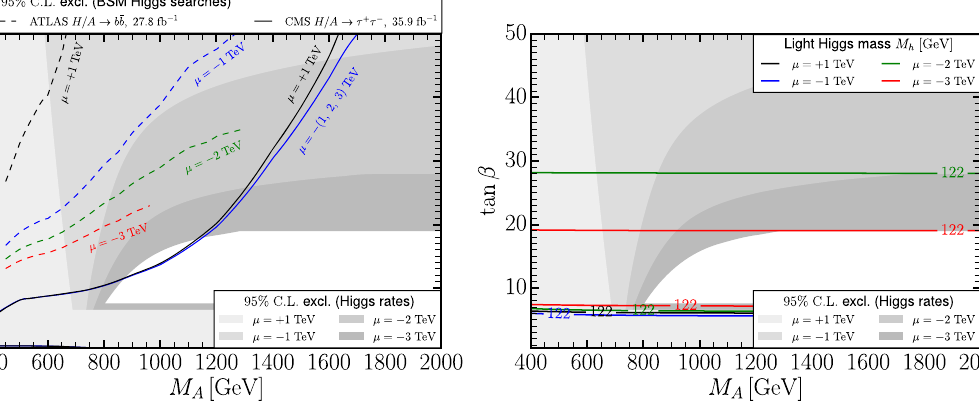
Fig. 1 M 125 scenarioincomparisonwiththeproposednew M 125 h − 2TeV ) scenario and the other choices of μ = − 1TeV , − 3TeV, shown in the ( M A , tan β ) parameter plane. Left panel: Current exper- imental constraints from heavy Higgs searches in the b ¯ b [67] (dashed lines) and τ + τ − [68] (solid lines) final state and 125GeV Higgs rate